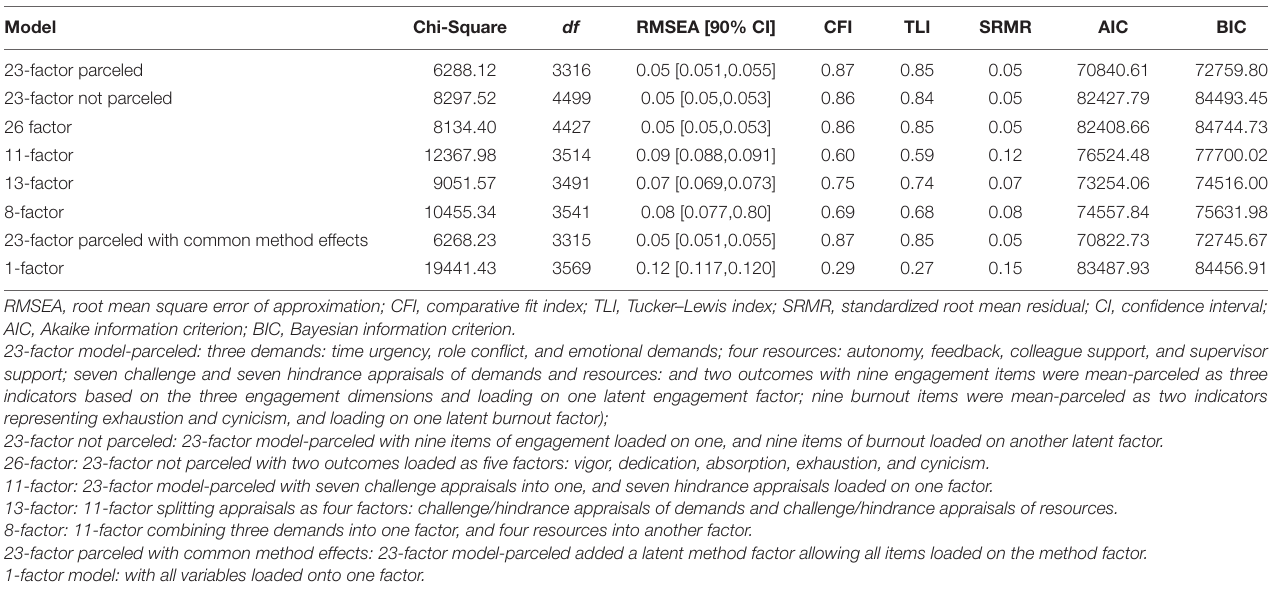
TABLE 6 | Results of confirmatory factor analyses in Study 2.